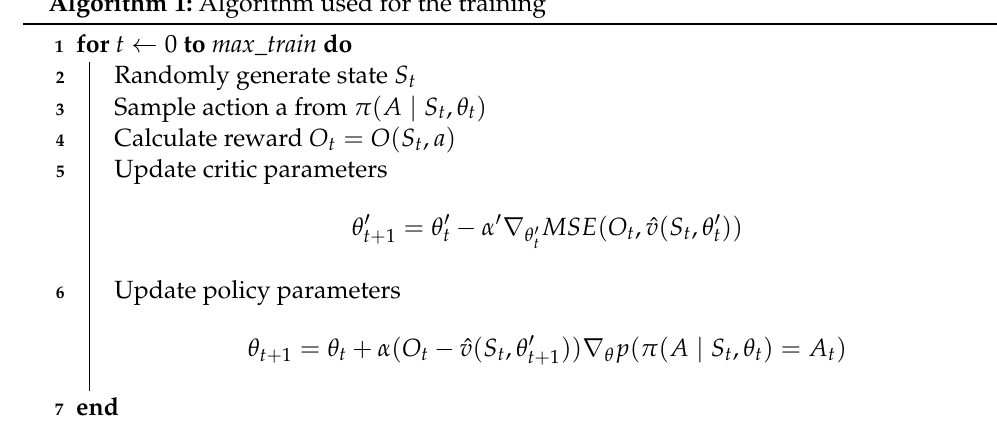
Algorithm 1: Algorithm used for the